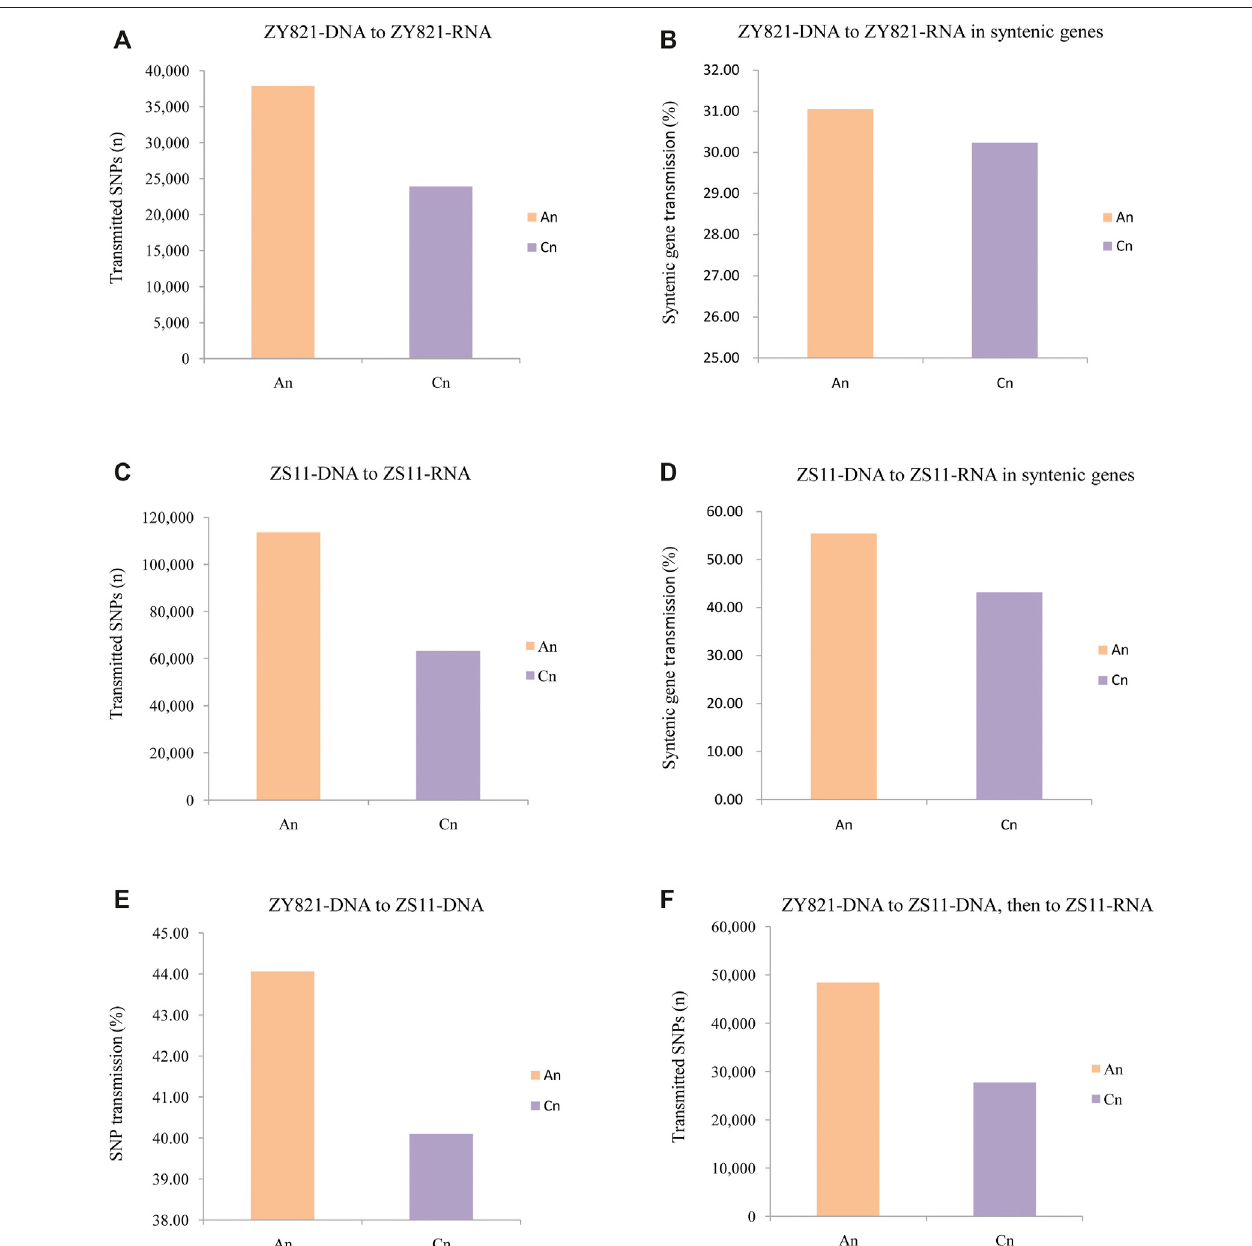
FIGURE 2 | Statistical analyses of transmitted SNPs in two subgenomes at different levels in two B. napus lines ZY821 and ZS11. (A) Rates of ZY821 genomic SNPs transmitted to the ZS11 genome. (B) Numbers ofZY821 genomic SNPs transmitted to theZY821 transcriptional level. (C) Rates ofSNPsin syntenic ZY821 genes transmittedfromgenometotheZY821transcriptionallevel. (D) NumbersofSNPstransmittedfromthegenomictothetranscriptionallevelinZS11. (E) Ratesofgenomic SNPsinsyntenicgenesofZS11transmittedtothetranscriptionallevel. (F) NumbersofgenomicSNPsfromZY821transmittedtotheZS11genomeandconserved at the transcriptional level in